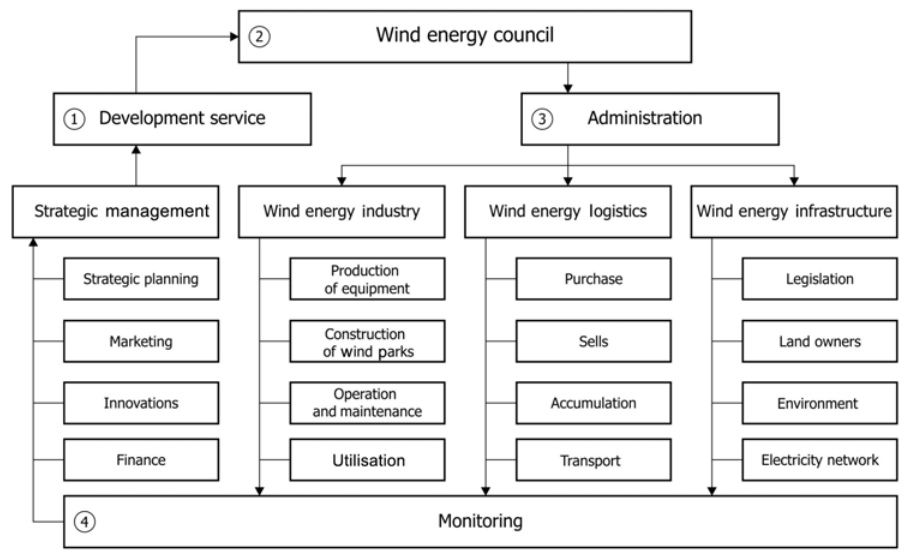
Fig. 5. The structure of Lithuanian wind energy